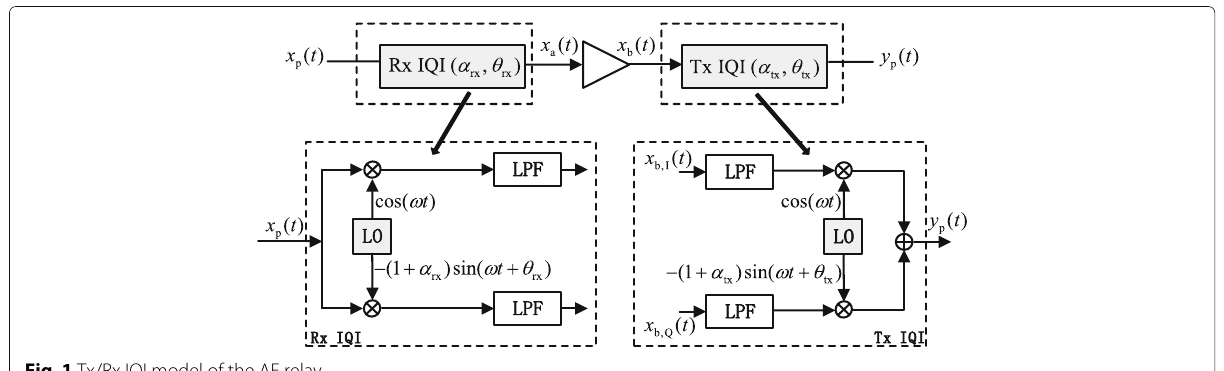
Fig. 1 Tx/Rx IQI model of the AF relay